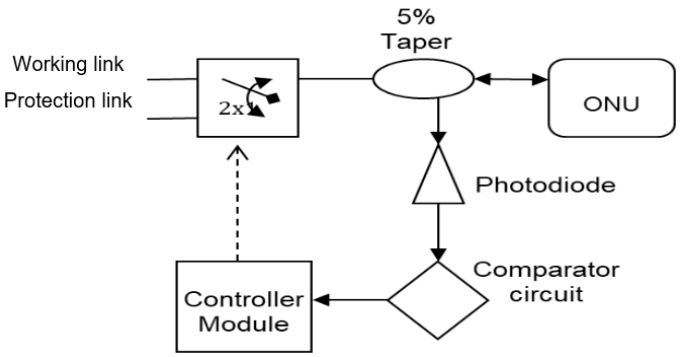
Figure 5. PROMO module block integrated with ONU.